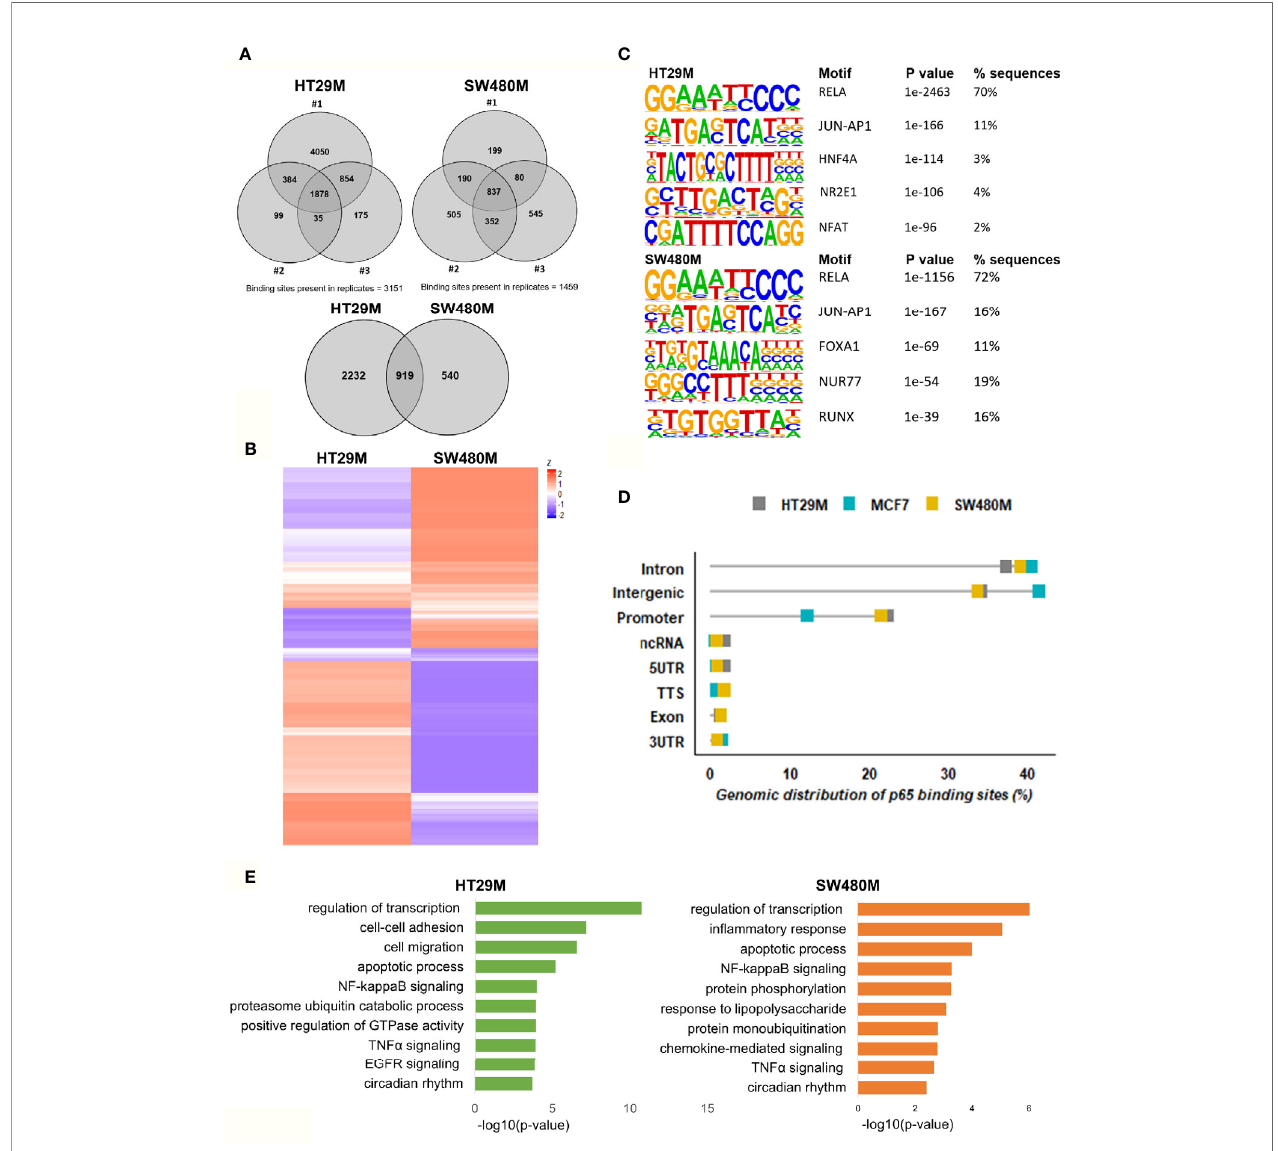
FIGURE 1 | Genomic distribution of p65 binding sites in colon cell lines. (A) Identi fi ed p65 binding sites in three replicates of colon cancer cell lines HT29 and SW480 with those detected in at least two replicates used for further analysis and highlighted (top), and their overlap between cell lines (bottom), represented using Venn diagram. (B) Heatmap representing p65 binding sites in the two cell lines. (C) Motifs highly enriched in p65 binding sites identi fi ed by HOMER using de novo motif analysis and sorted by p-value. (D) Genomic distribution of p65 binding sites in relation to gene locations. (E) Biological functions enriched in genes nearest p65 binding sites (-50kb